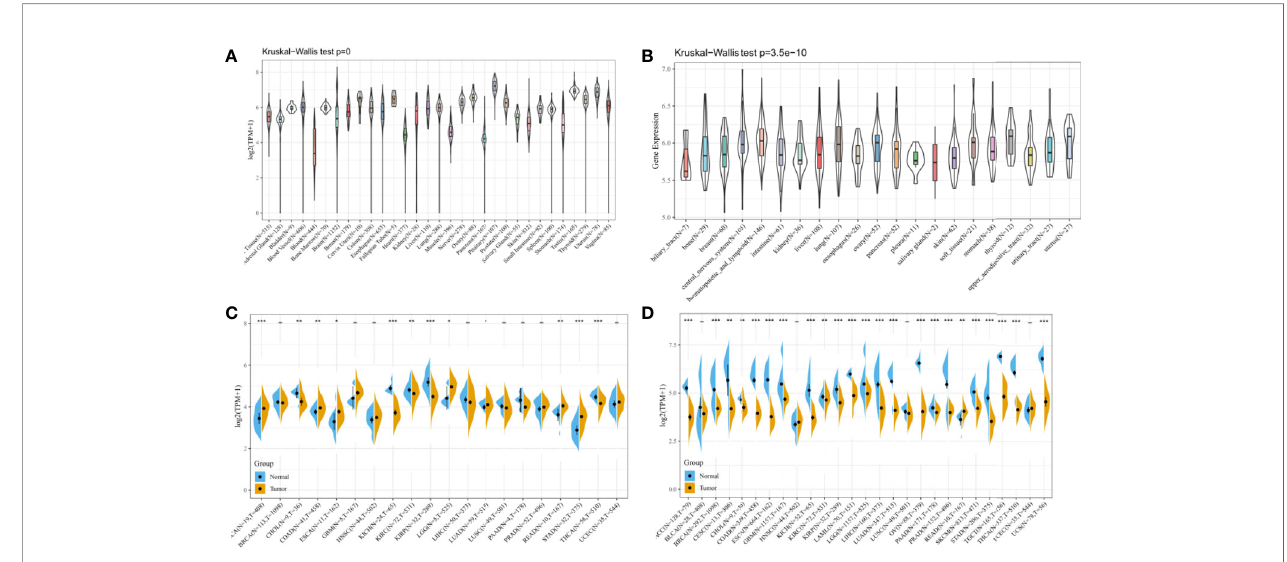
FIGURE 1 | Expression levels of HDAC6 in pan-cancer. (A) Analysis of HDAC6 expression levels in pan-cancer based on the GTEx dataset. (B) Analysis of HDAC67nbsp;expression levels in various cancer cells based on the CCLE dataset. (C) Analysis of HDAC6 expression levels in pan-cancer based on TCGA database. (D) Integration of GTEx and TCGA databases to obtain 27 tumor modules and to analyze HDAC6 expression levels in tumor modules. * indicates P < 0.05 compared with control, ** indicates P < 0.01 compared with control, *** indicates P < 0.001 compared with